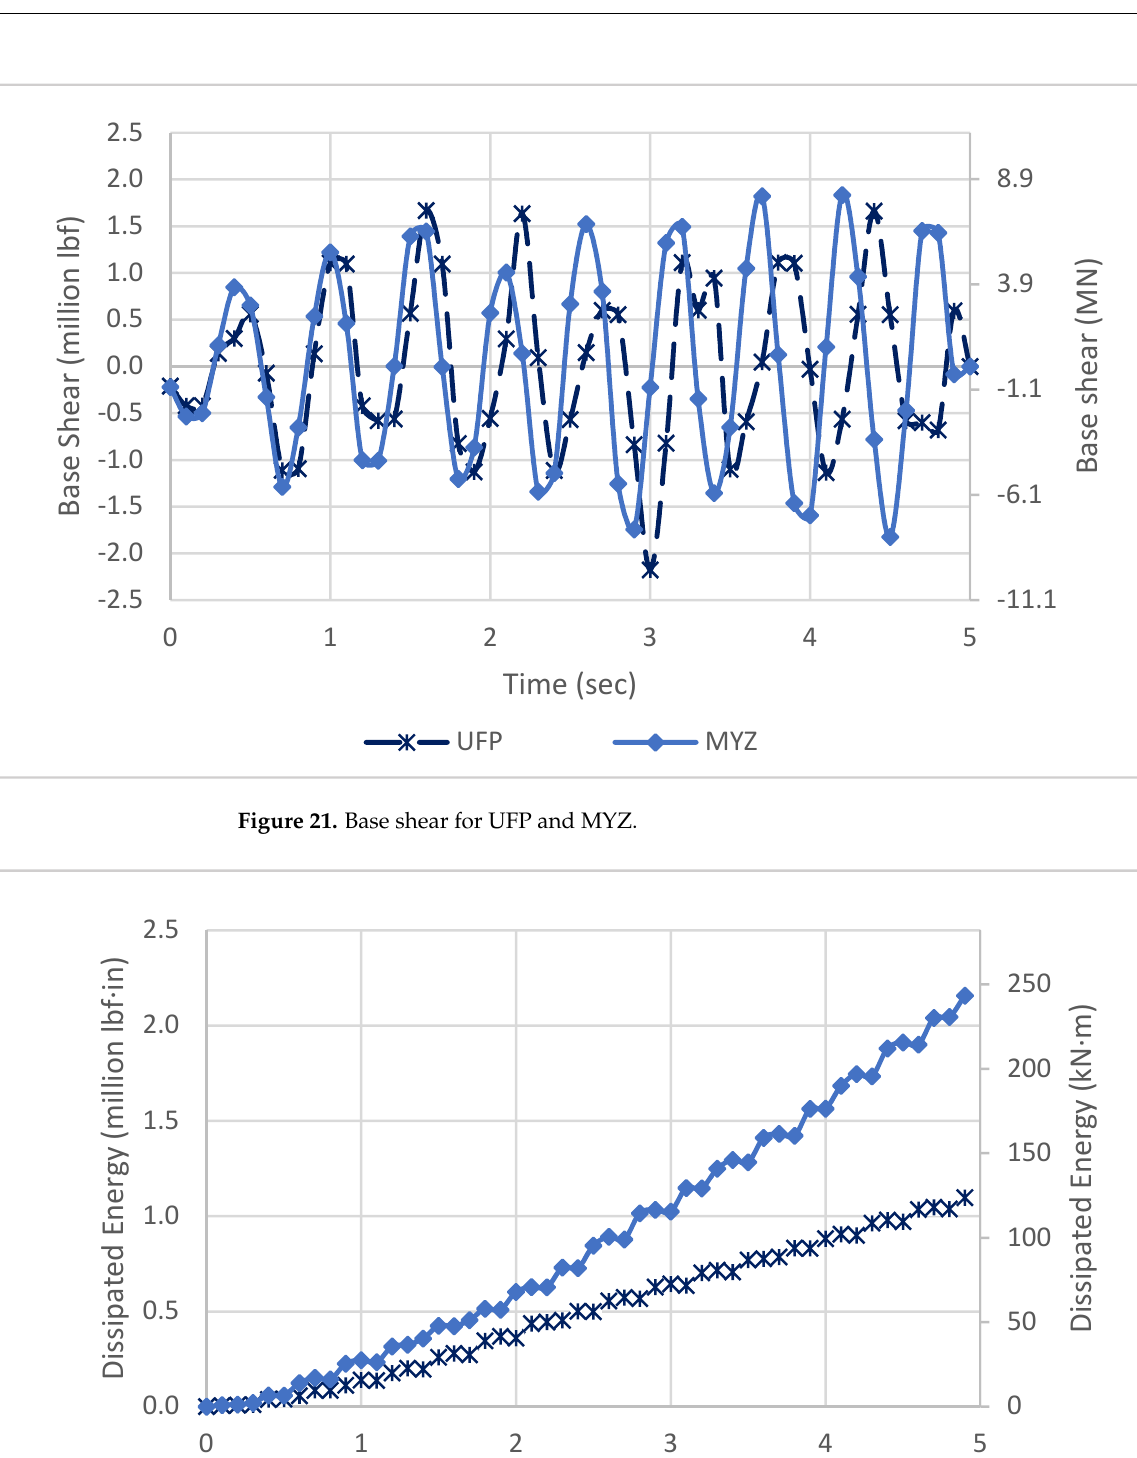
Figure 22. Cumulative dissipated energy for UFP and MYZ.